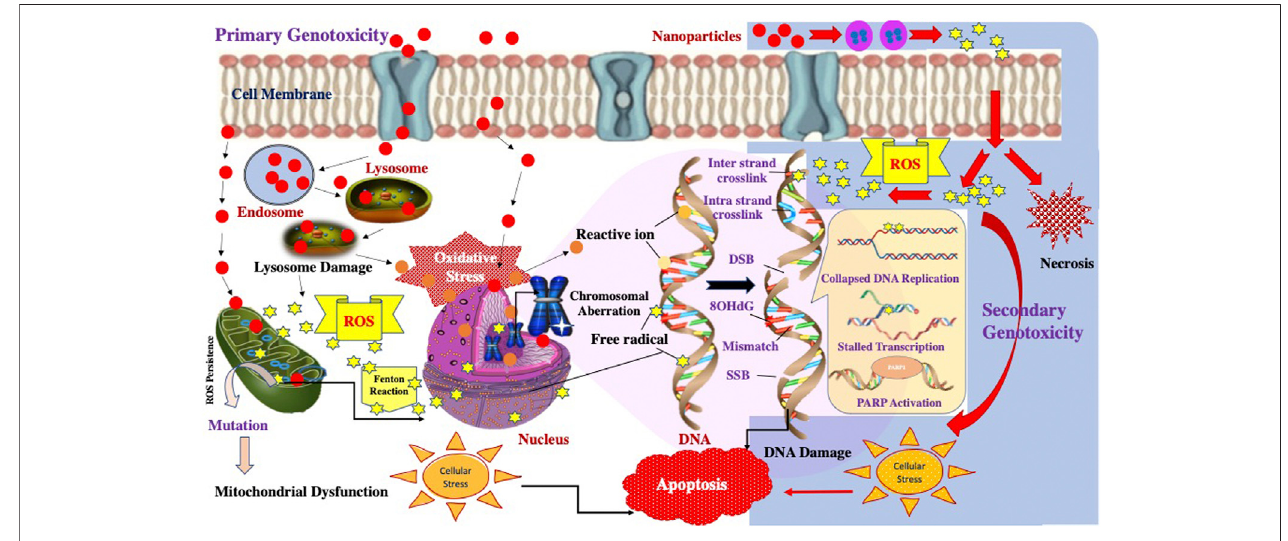
FIGURE 3 | Schematic representation of the possible Primary and Secondary Genotoxicity mechanisms induced by nanoparticles.